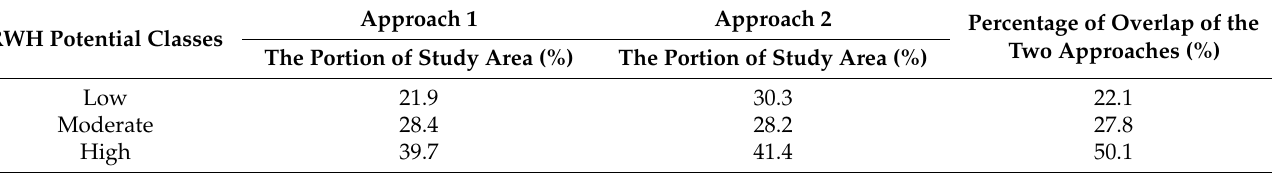
Table 6. Three classes of potential RWH in the two approaches after sensitivity